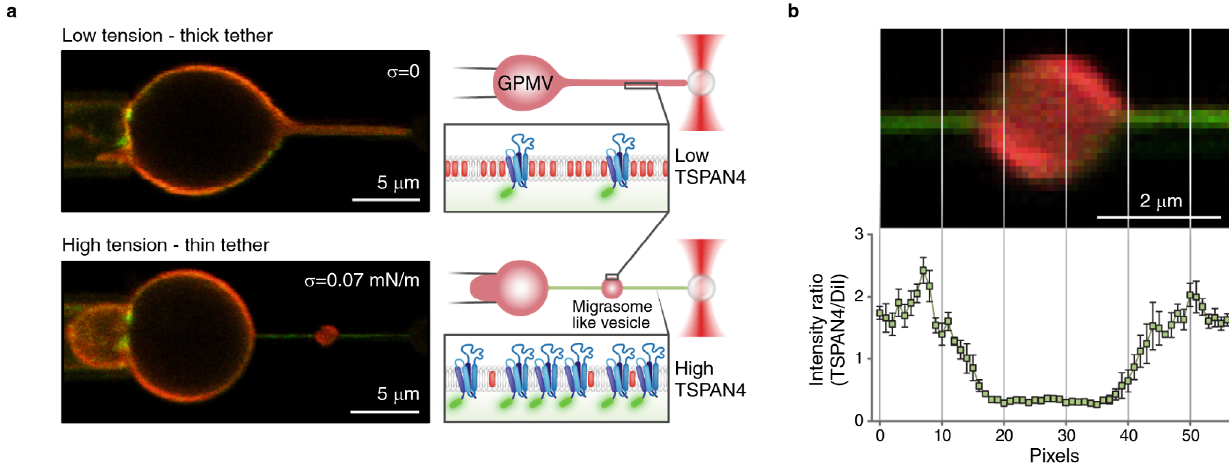
b TSPAN4-GFP and DiI-C12 fl uorescence intensity ratio of membrane tubes con- tainingaswelling( n =4membranetubes,having swelling withrelativelysamesize, pulledfrom4vesiclesfrom3independentexperiments,errorbarsareSEM).Onthe top,arepresentativeimageofamembranetubecontainingaswelling.Sourcedata are provided as a Source Data fi le.